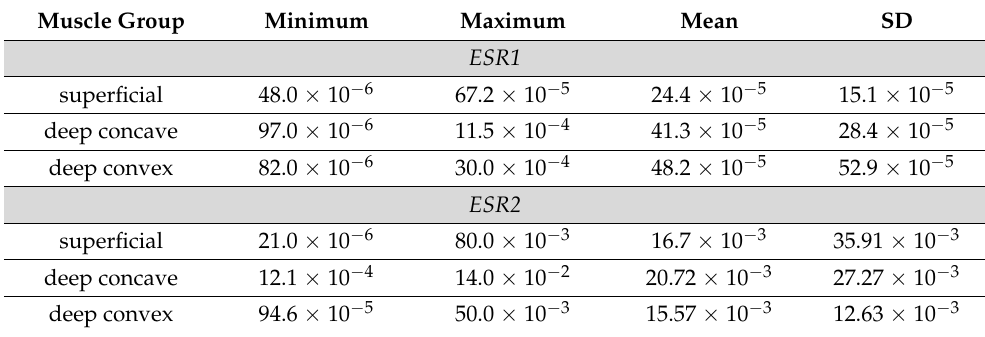
Table 4. ESR1 and ESR2 expression levels in superficial and deep back muscles in 35 cases. Muscle